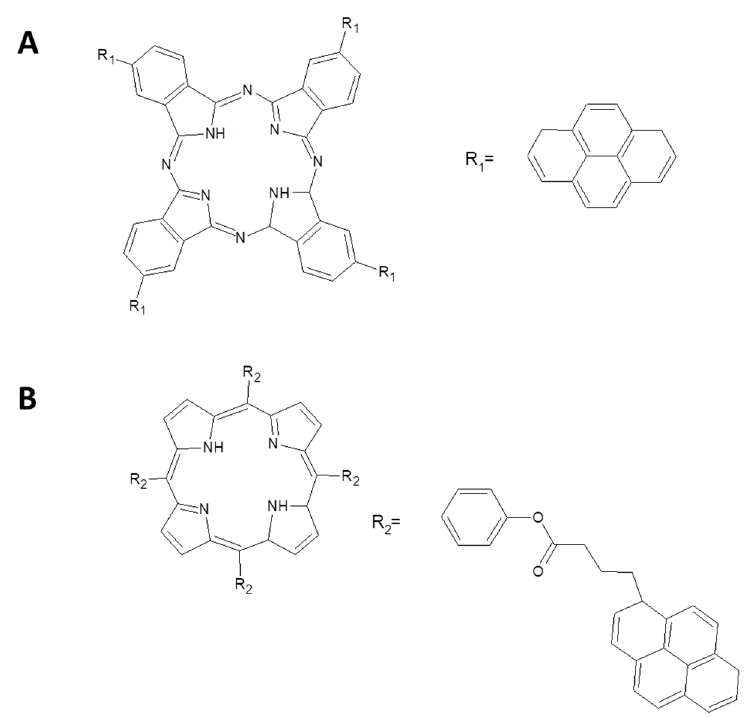
Figure 16. Structures of ( A ) phthalocyanine directly linked to four pyrene entities and ( B ) porphyrin linked to four entities of pyrene [101].